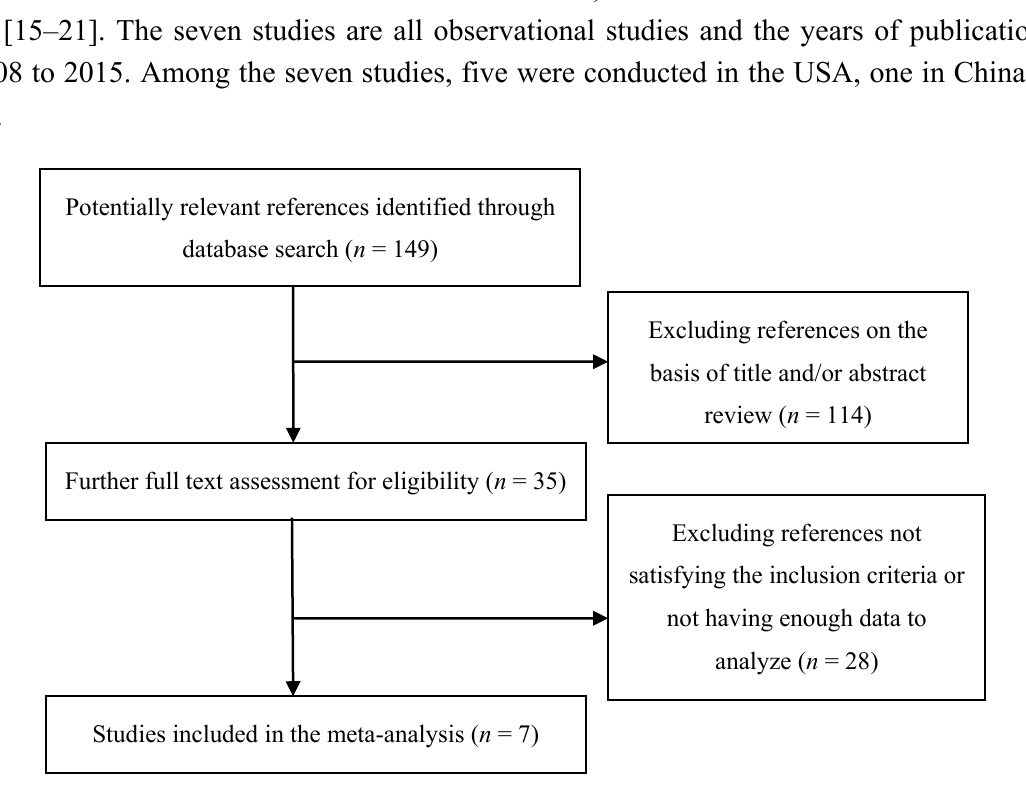
Figure 1. Flow diagram of literature search and identification of relevant